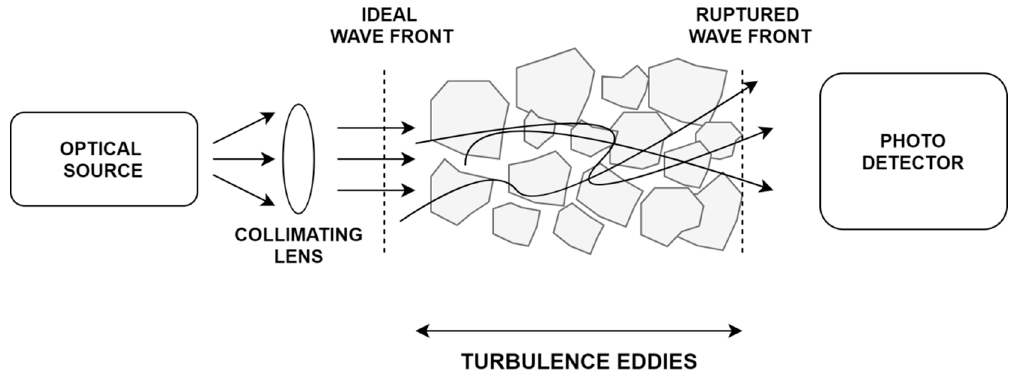
Figure 3. Formation of turbulence eddies leading to random fluctuation and ruptured wavefront in FSO links.